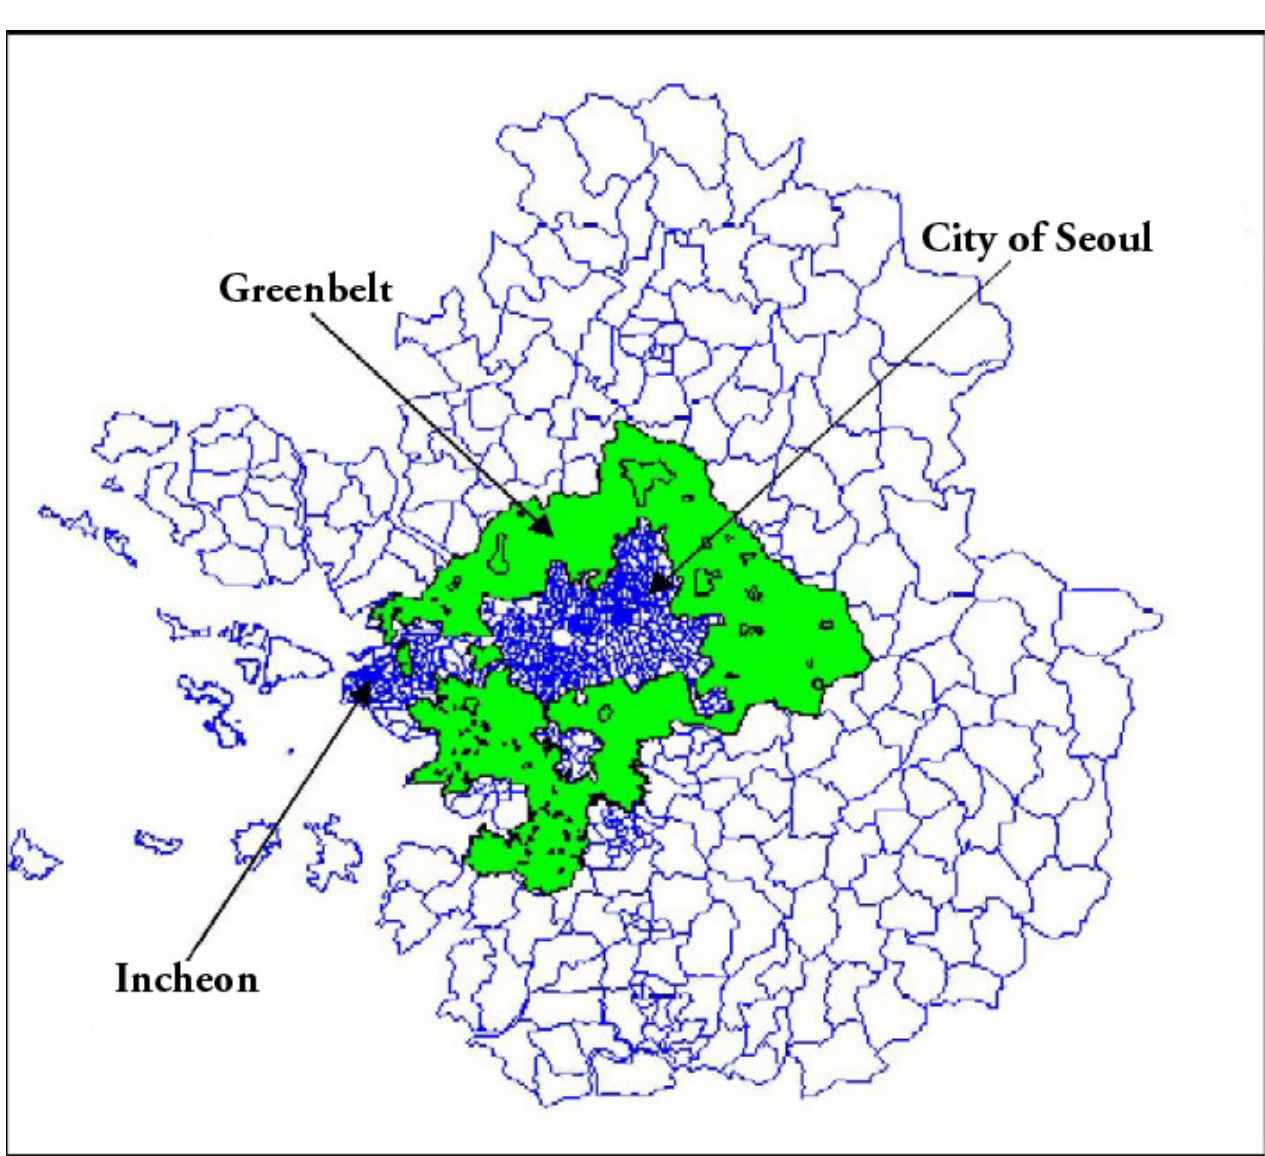
Fig. 1. Map of Gyeonggi Province and Seoul's